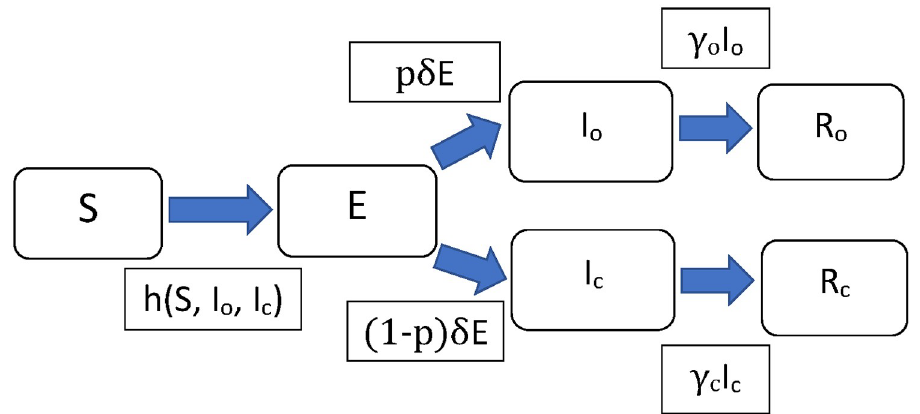
Fig 2. Flow chart of the modified SEIR model. Compartments of the modified SEIR model and their associated parameters.